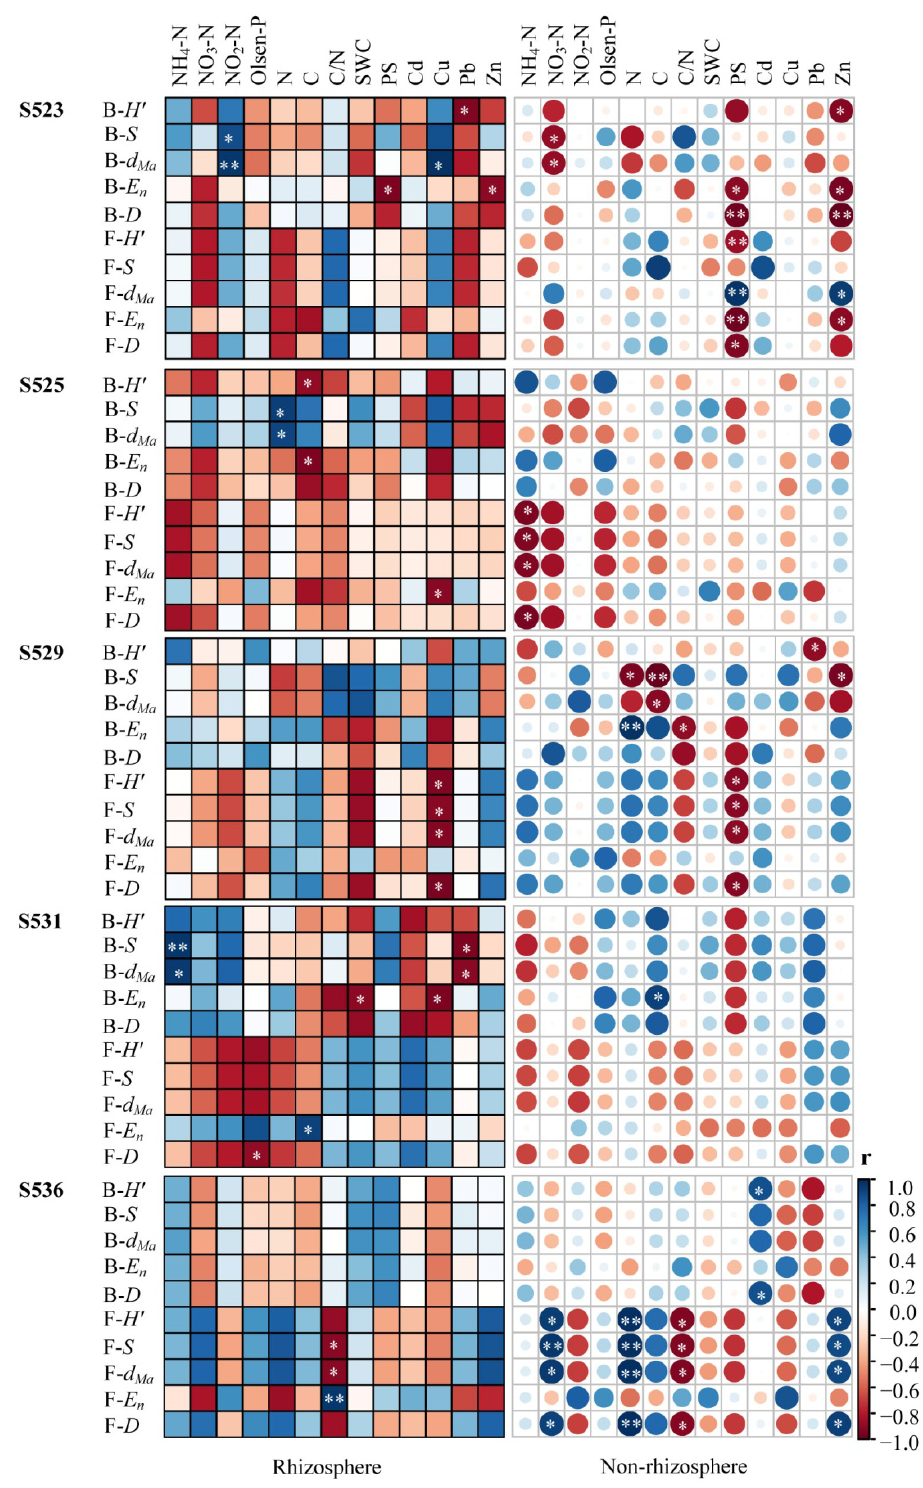
Figure 5. The Pearson correlations between soil properties and Shannon-Wiener index ( H’ ), species richness ( S ), Margalef ( d Ma ), evenness ( E n ) and the Simpson index ( D ) of rhizosphere and non-rhizosphere soil bacteria (B) and fungi (F) community in different sub-dams. Soil properties include total nitrogen (N), total carbon (C), total sulphur (S), and a ratio of carbon and nitrogen (C/N). ** Correlation is significant at the 0.01 level (2-tailed). * Correlation is significant at the 0.05 level (2-tailed).